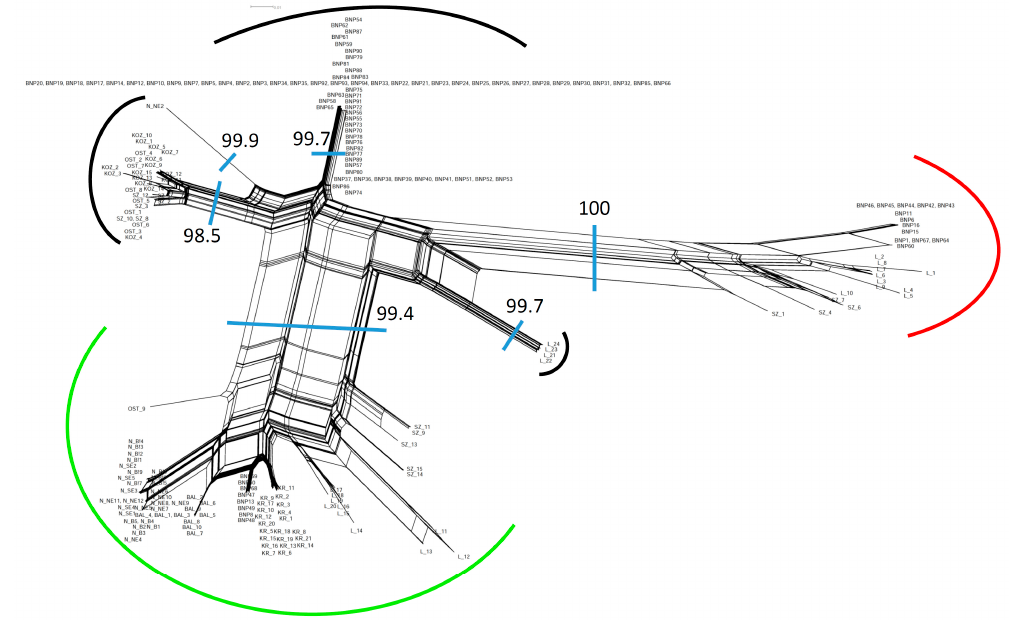
Figure 6. NeighborNet analysis of studied individuals of V. epipsila (red line), V. palustris (green line) and their putative hybrids (black lines) based on Dice coefficient from ISSR data. Bootstrap analysis was performed on 2000 replicates. Origin of samples: Germany (N), Poland (BAL, BNP, KR, KOZ, OST, and SZ) and Lithuania (L). Detailed information in Table S1. Table 3. Results of the three-level AMOVA, based on ISSR profiles scored from total of 10 populations of V. epipsila , V. palustris , and their putative hybrids.